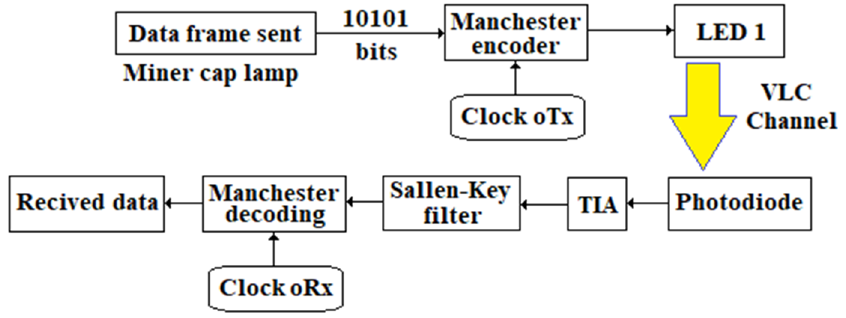
Figure 22. Block diagram of the VLC communication system.